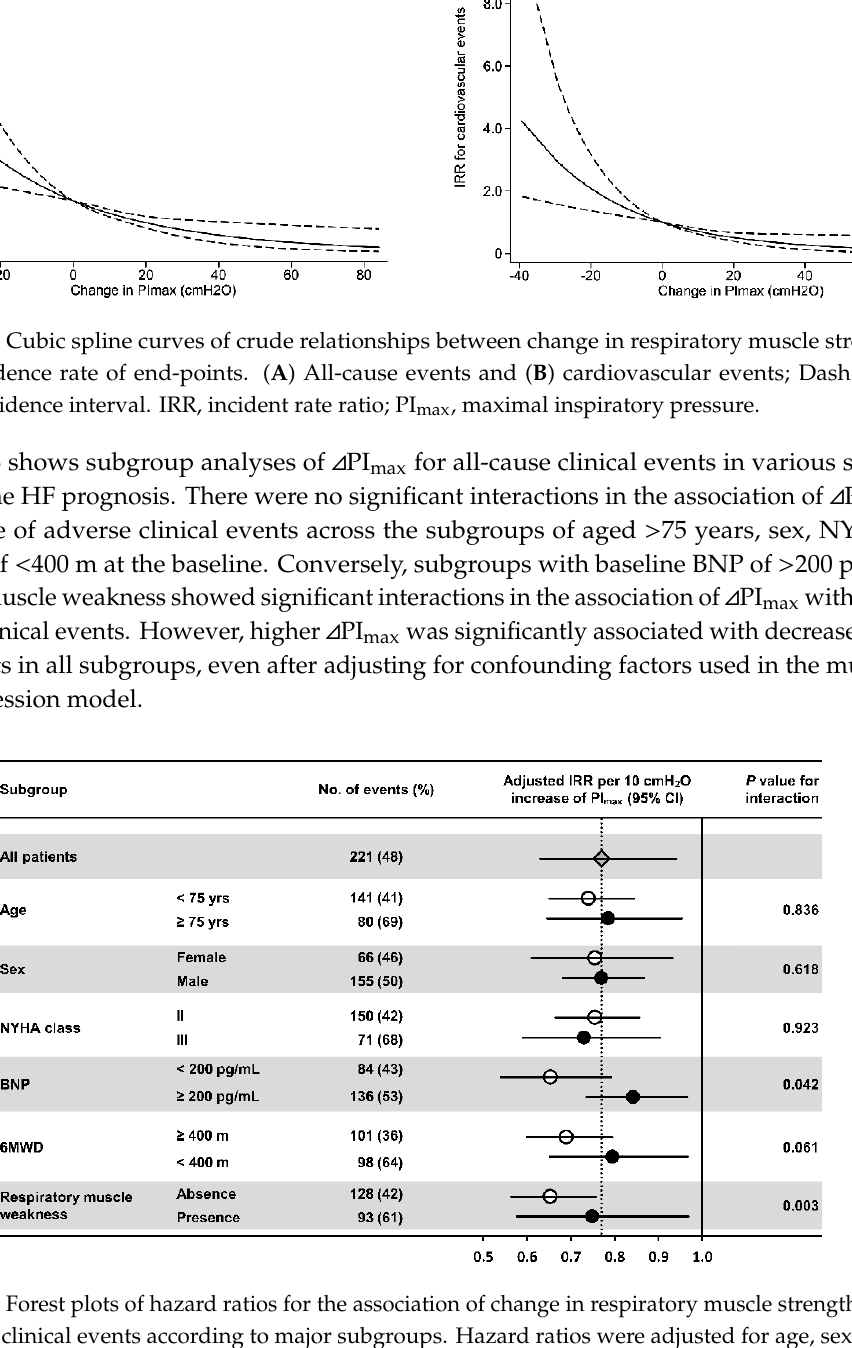
in PI max per 10 cmH 2 O had significant trend relationships with a decreased rate of all-cause